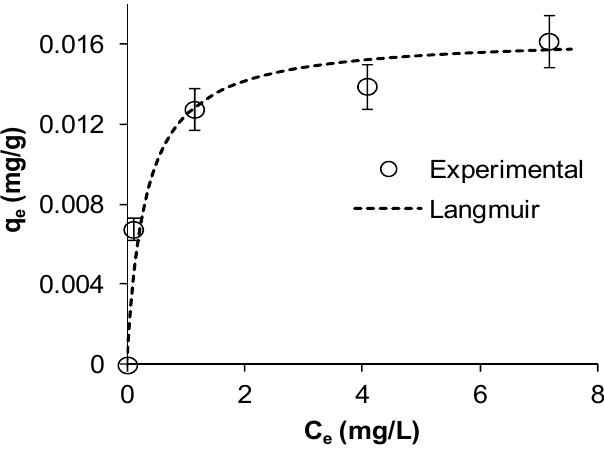
Table 2. Separation factor values for copper sorption by manganese coated sand (MCS)